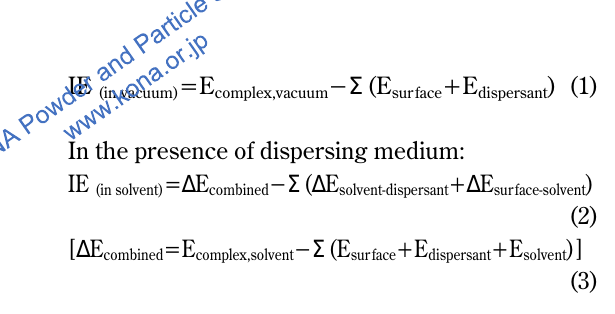
( Figure 2 ). The authors defined a dispersibility index in percent based on sediment volume measure- ments. Higher the value of this index the better is the dispersion. The theoretical predictions match well with the experimental findings.